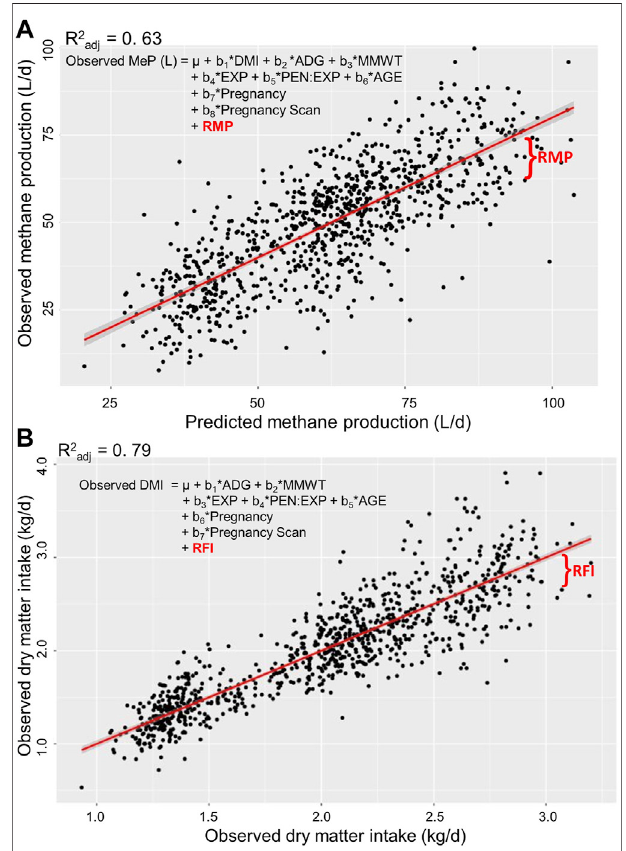
FIGURE 1 | Estimation of residual traits in post-weaning, hogget, and adult Australian Maternal Composite sheep. Residual methane production [RMP; (A) ]istheresidualofobservedmethaneproduction(MeP)regressedon predicted MeP. Residual feed intake RFI; (B) is the residual of observed daily dry matter intake (DMI) regressed on predicted DMI. Regressors: DMI, average daily gain (ADG), metabolic mid-weight (MMWT), experiment (EXP), pen nested into EXP (PEN: EXP), and age at the start of the test (AGE).